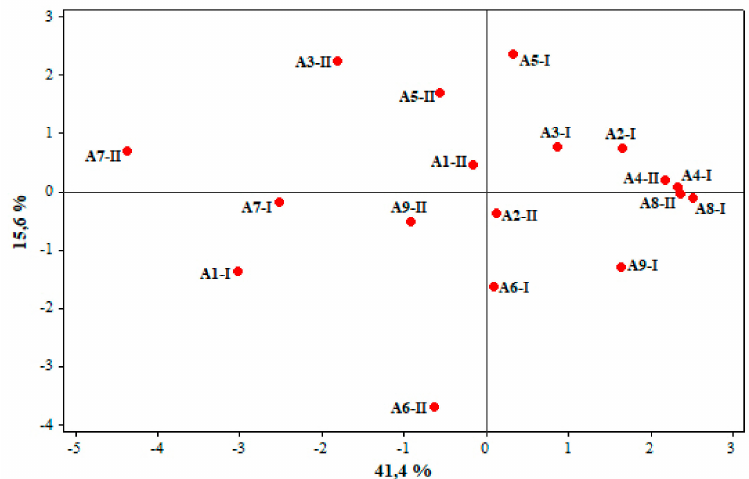
Figure 3. Principal Component Analysis applied to the volatiles identified in the first (I) and second (II) replicates of each pasture